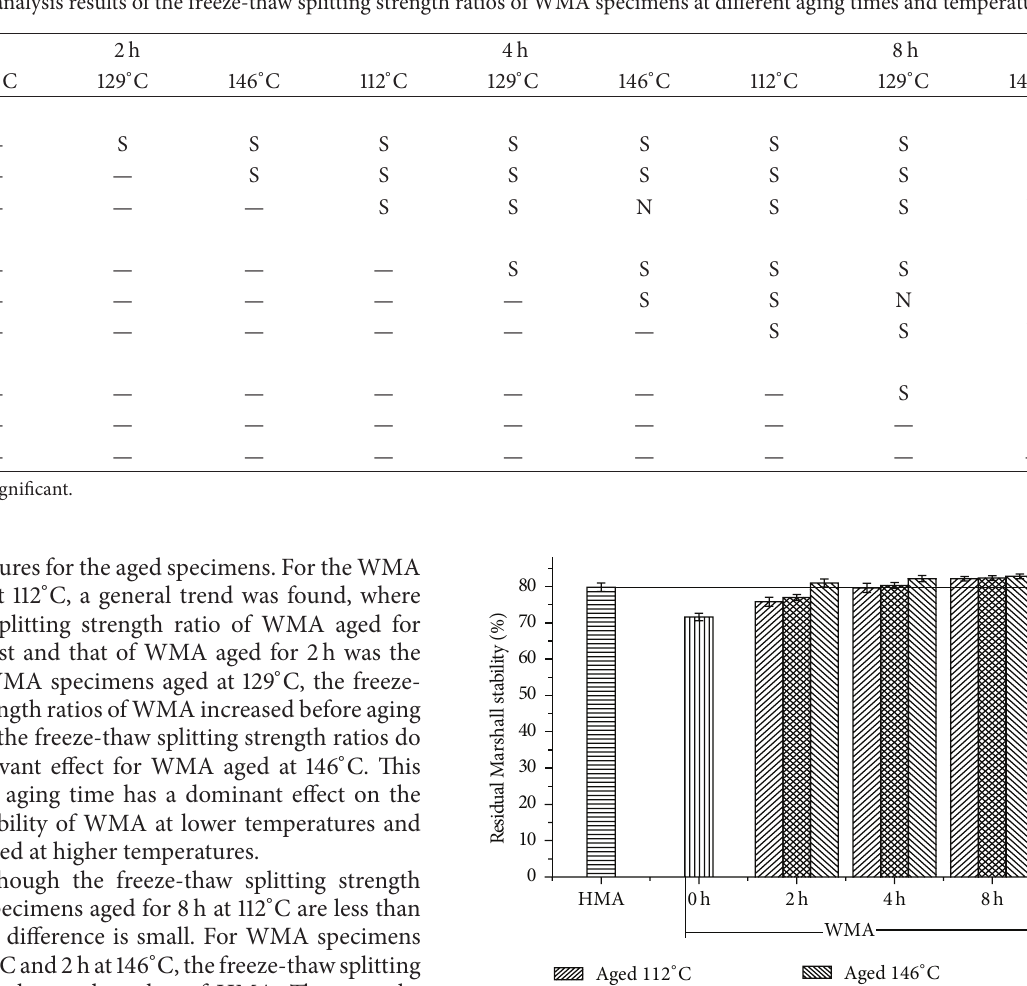
Table 3: Statistical analysis results of the freeze-thaw splitting strength ratios of WMA specimens at different aging times and temperatures.